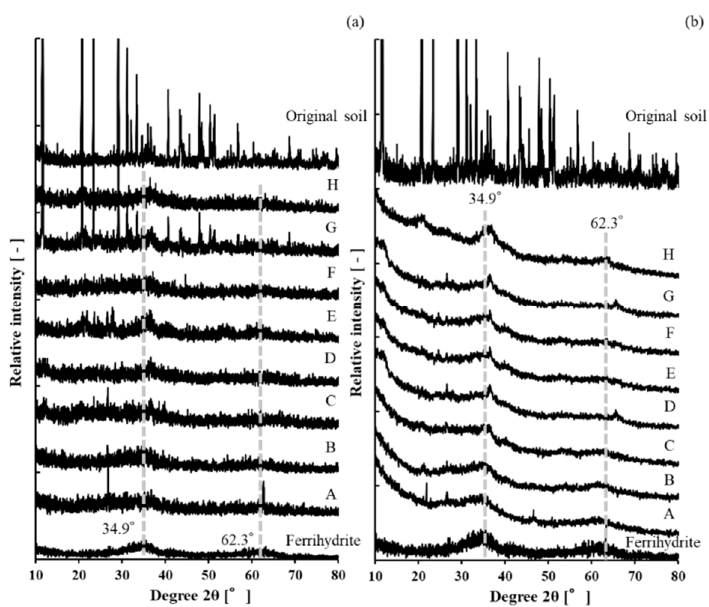
Figure 4. X-ray diffraction patterns of sediment samples ( a ) in summer and ( b ) winter. Figure 4. X-ray di ff raction patterns of sediment samples ( a ) in summer and ( b )